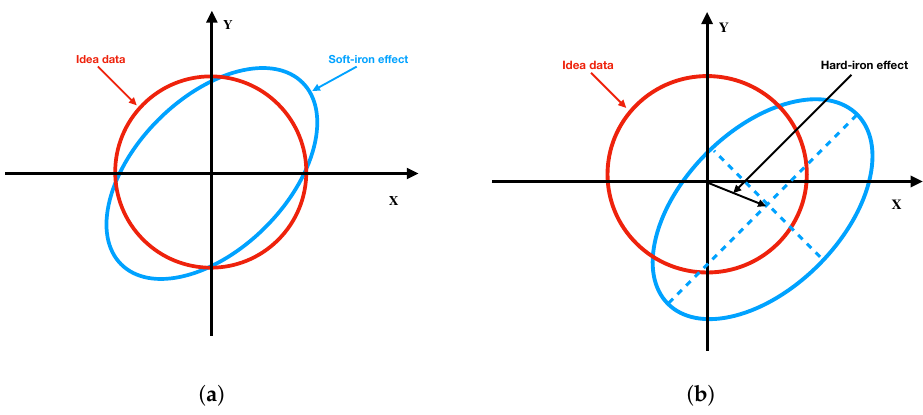
Figure 3. Soft and hard iron effects: ( a ) soft iron effect; ( b ) hard iron